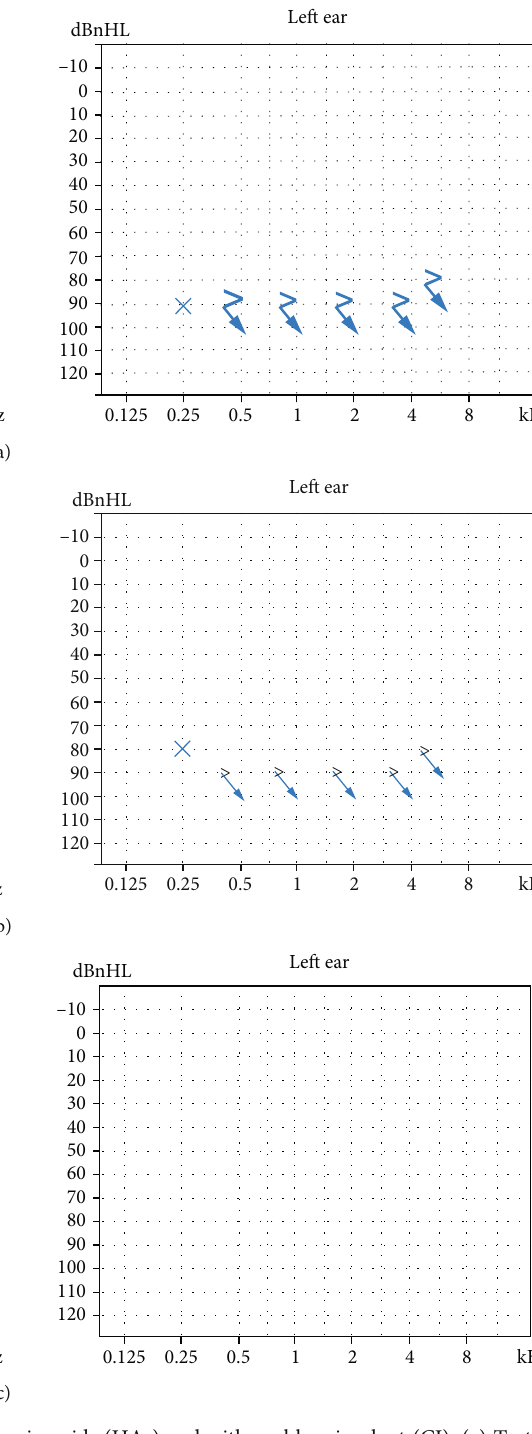
Figure 2: CPA results for proband 1-II-1 before and after wearing hearing aids (HAs) and with cochlear implant (CI). (a) Testing results before wearing hearing aids. (b) Testing results after fi tting of hearing aids. (c) Sound fi eld thresholds of the right ear 3 months after CI surgery. Arrows: no response at the speci fi c frequency. Cross and circle: threshold at the speci fi c